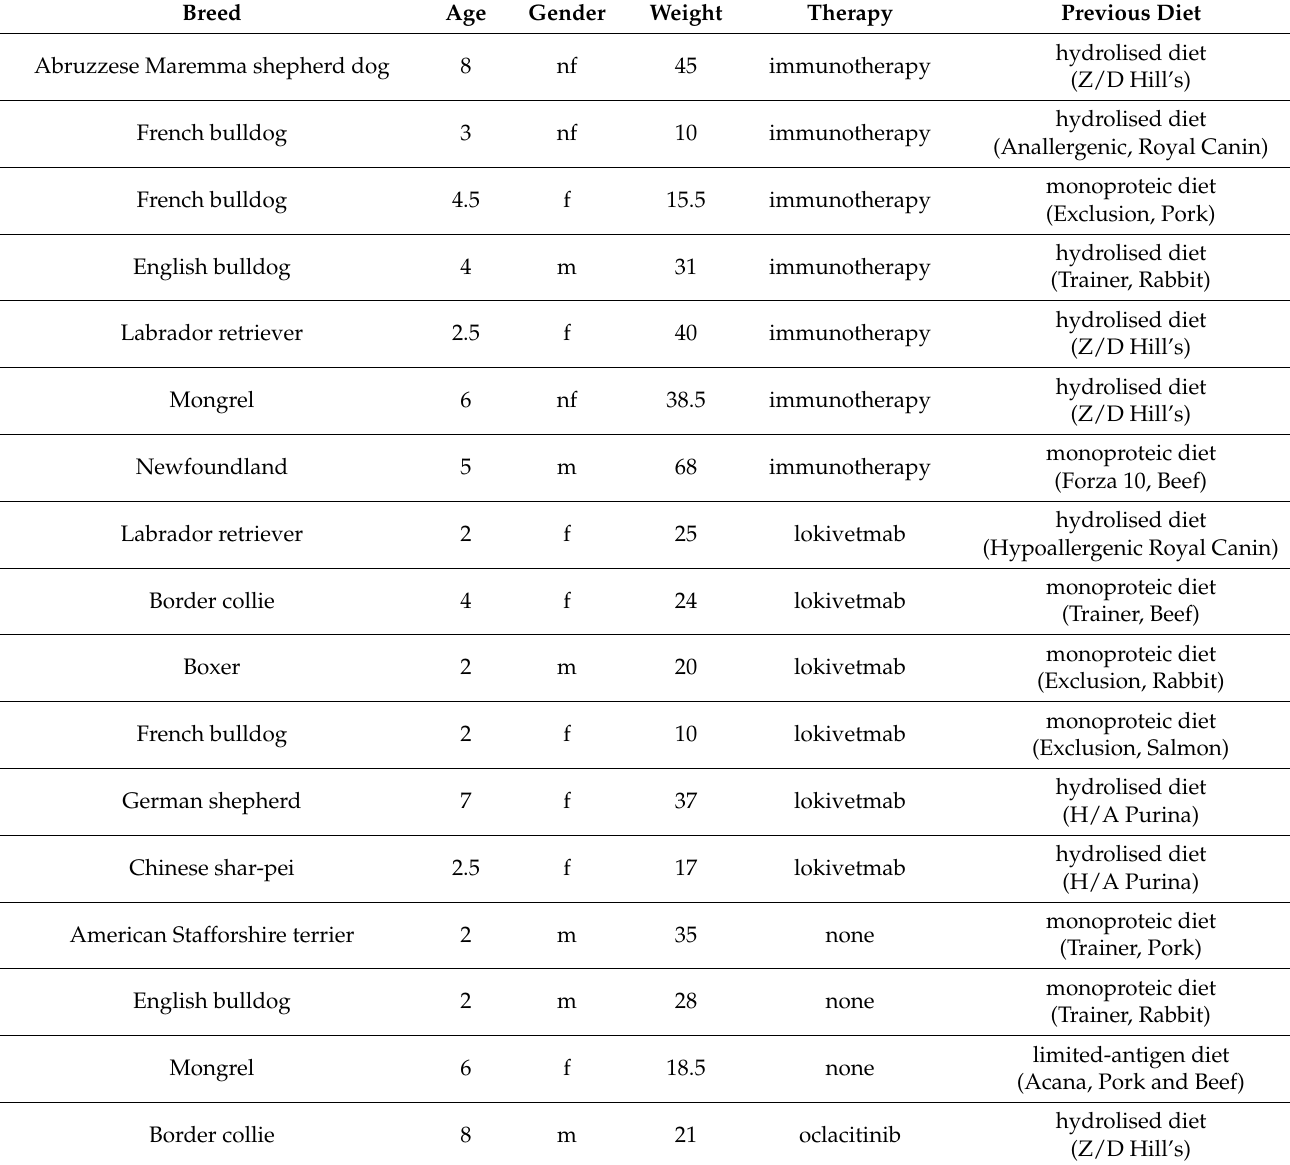
Table 1. Dogs with atopic dermatitis that finished the